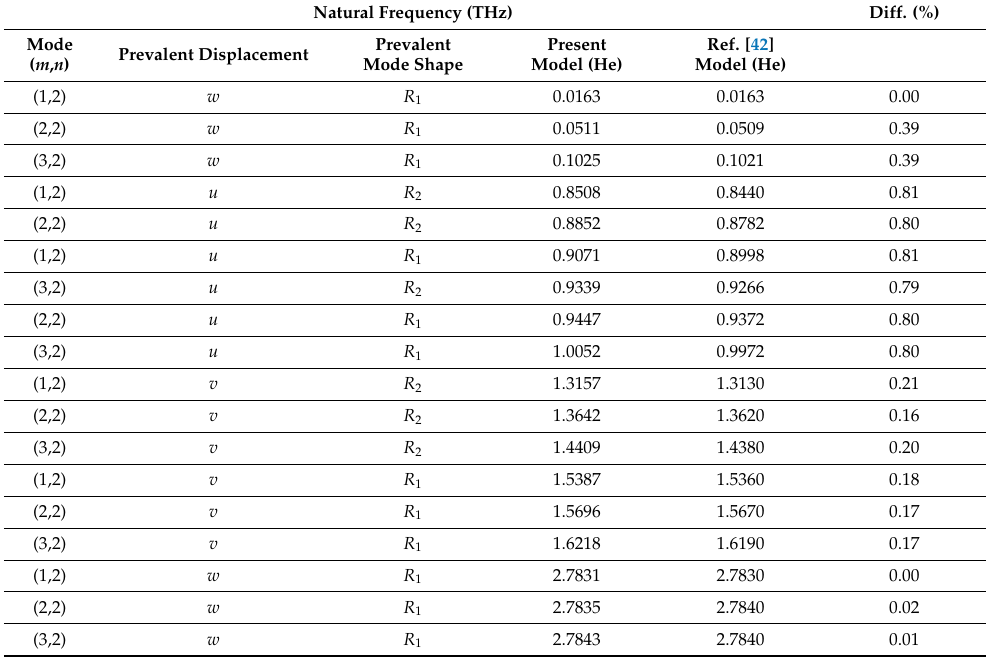
Table 4. Natural frequencies (THz) of a simply supported DWCNT with innermost radius R 1 = 5 nm and aspect ratio L / R 2 = 10. Donnell shell theory. Isotropic elastic shell model. Van der Waals interaction coefficient expressed on the basis of He’s formulation. Circumferential flexure modes ( n = 2). Comparisons between present and Ref. [42]